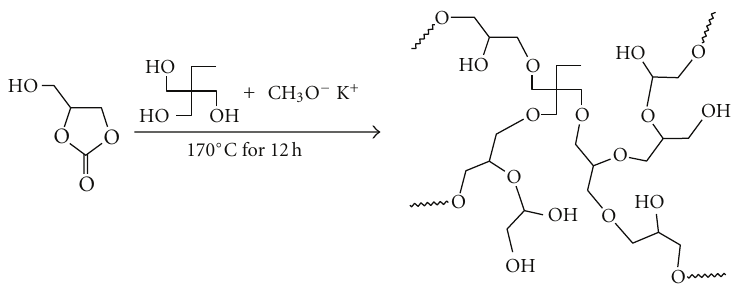
Scheme 7: Synthesis of hyperbranched polyglycerol from glycerol carbonate.